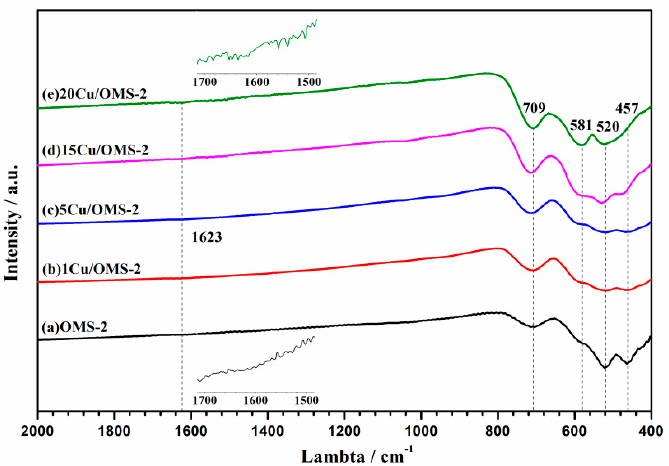
Figure 2. FT-IR spectra of ( a ) OMS-2, ( b ) 1Cu/OMS-2, ( c ) 5Cu/OMS-2, ( d ) 15Cu/OMS-2, and ( e ) 20Cu/OMS-2.